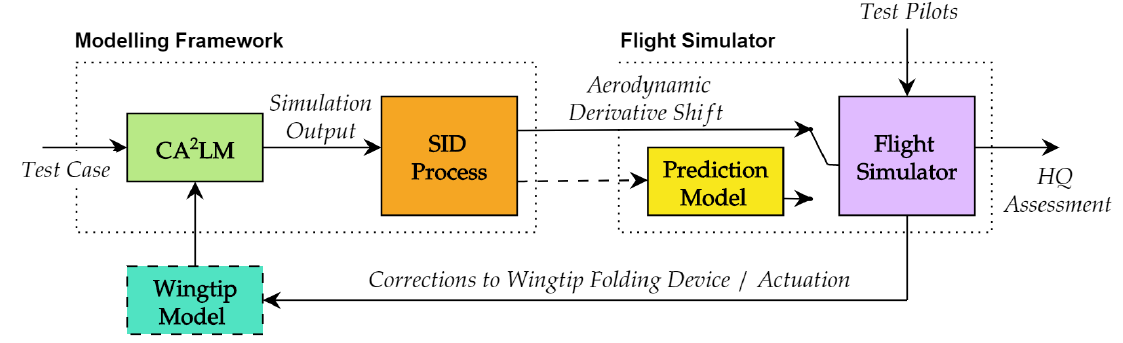
Figure 1. Scope of the aerodynamic derivative coefficient